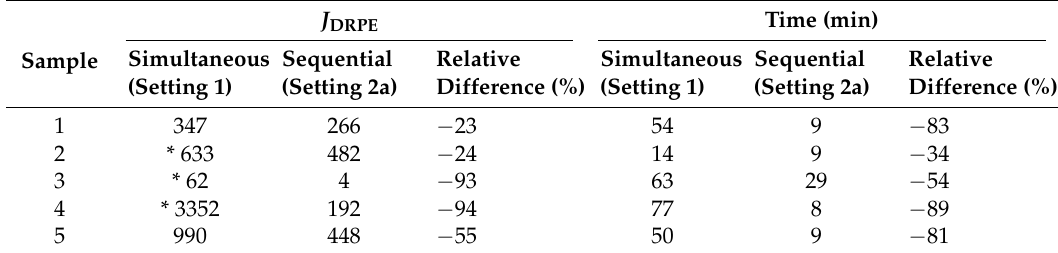
Table 6. Objective function values and computational cost as a function of solution